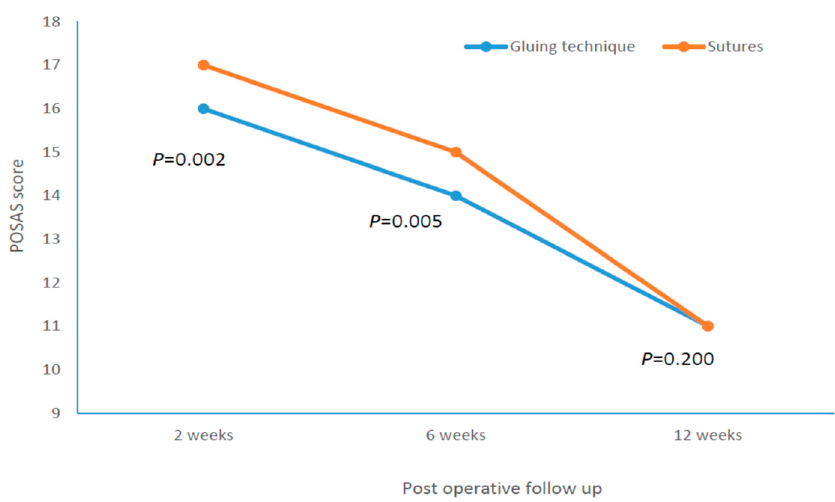
Figure 3. A regression graph (black line) and circles as a cases with the regression equation demon- strated a moderate correlation between the body mass index and POSAS score of the patient in the